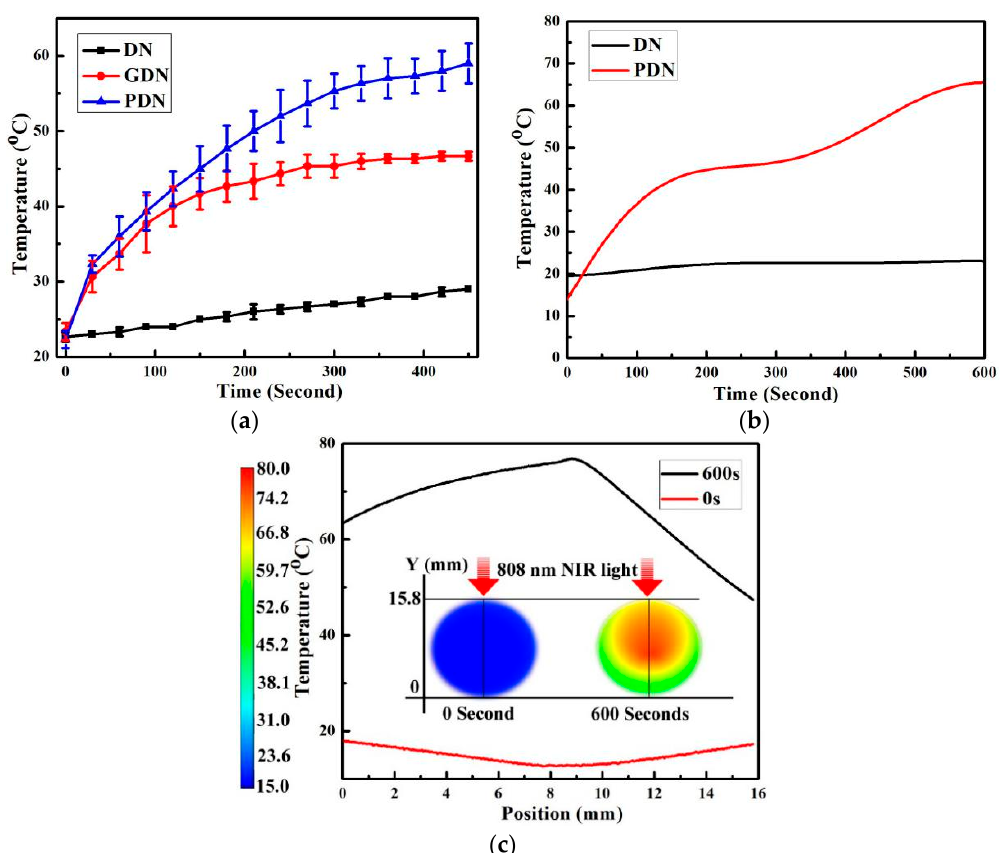
Figure 6. ( a ) Temperature change of DN, GDN, and PDN hydrogels with NIR laser irradiation (808 nm, 2.5 W cm − 2 ) detected by a thermometer, ( b ) fitted curve of average temperature of DN and PDN hydrogels with NIR laser irradiation (808 nm, 2.5 W cm − 2 ) for 10 min detected by a high-precision digital thermometer (Omega), and ( c ) infrared images of temperature distribution in DN and PDN gels with NIR laser irradiation (808 nm, 2.5 W cm − 2 ) for 600 s.